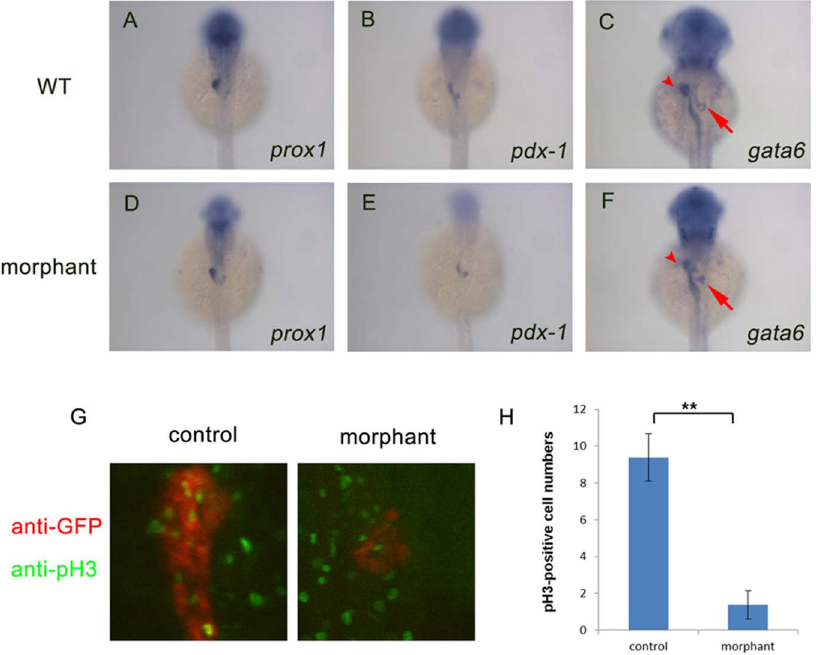
Figure 4. Nom1 is indispensable for pancreas proliferation but not for specification. (A–F) Dorsal views, anterior to the top. (A, B) Expression of prox1 (D, E) and pdx-1 (C, F) in the nom1 morphants is comparable to that in WT embryos at 36 hpf but reduced gata6 expression in liver (arrow) and pancreas (arrowhead) of nom1 morphants is obvious. (G) Anti-phospho Histone H3 (pH 3) staining for control and nom1 morphant embryos at 3 dpf. Red: GFP staining. Green: pH 3 staining. The signal of pH 3 staining in the pancreas of morphants is recognizably decreased. (H) Quantification of pH 3-positive cell numbers. Data were collected from 10 embryos. Error bars mean 6 SD. ** P , 0.01.